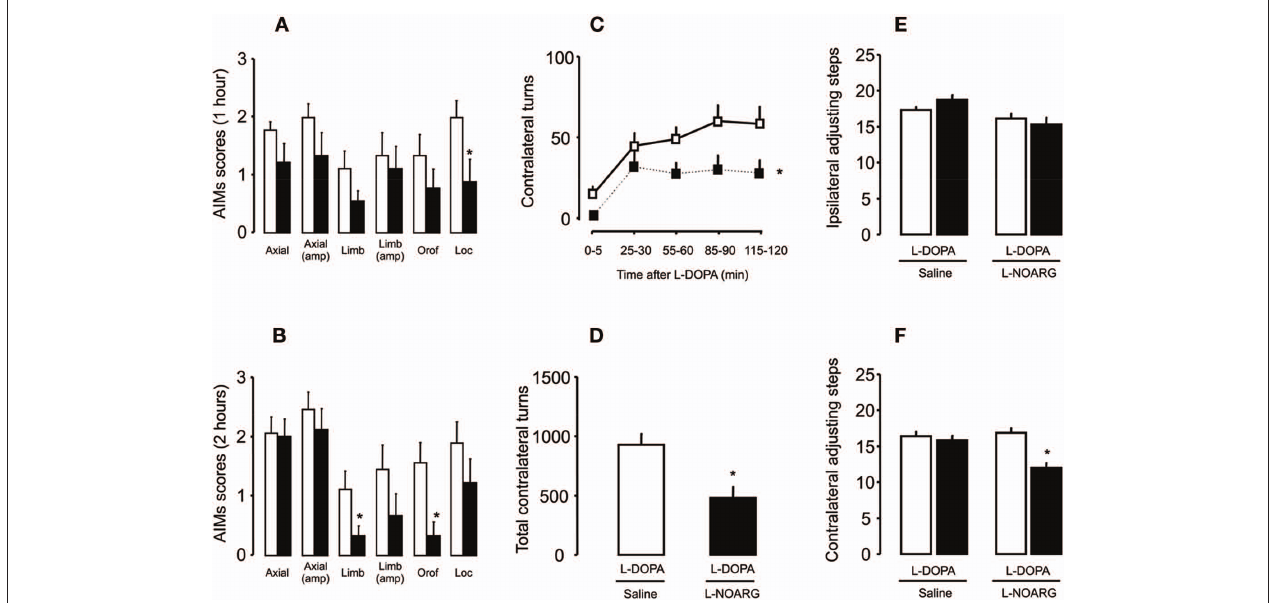
* p < 0.05 (one way rANOVA). (D) l -NOARG reduced total contralateral turns measured during 120 min after l -DOPA. p < 0.05 (paired t-test). After chronic l -DOPA treatment l -NOARG pre-treatment did not affect (e) ipsilateral adjusting steps and (F) slight reduced adjusting steps performed with contralateral paw. * p < 0.05 vs Saline-FPM (one way rANOVA). Values are expressed as mean ± SEM (6-OHDA-FPM, n = 8–9/group; Saline-FPM, n =